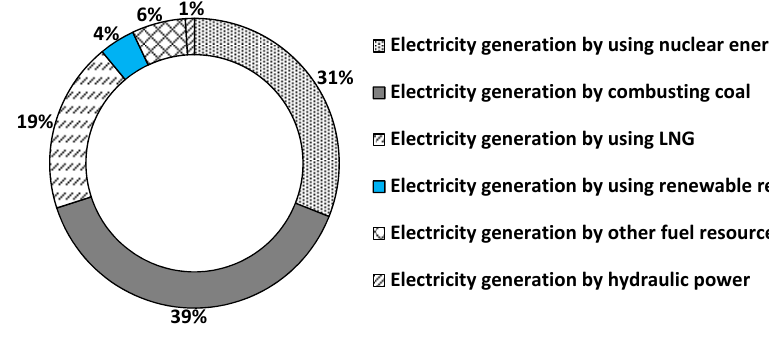
Figure 1. Electricity generation system in Korea.